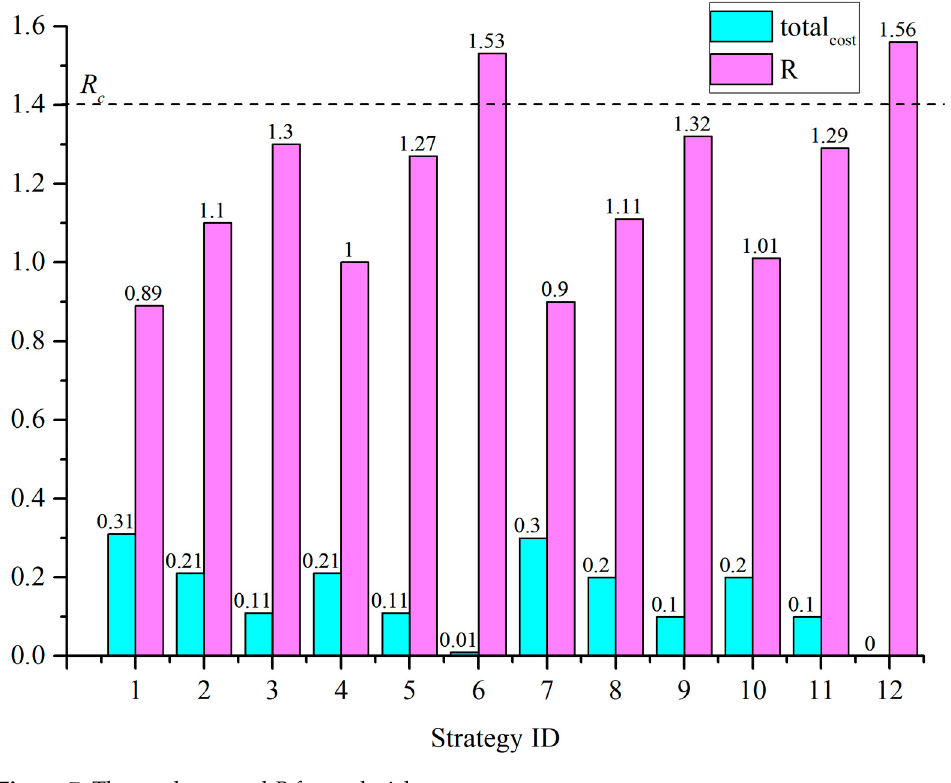
Figure 7. The total cost and R for each risk treatment strategy.